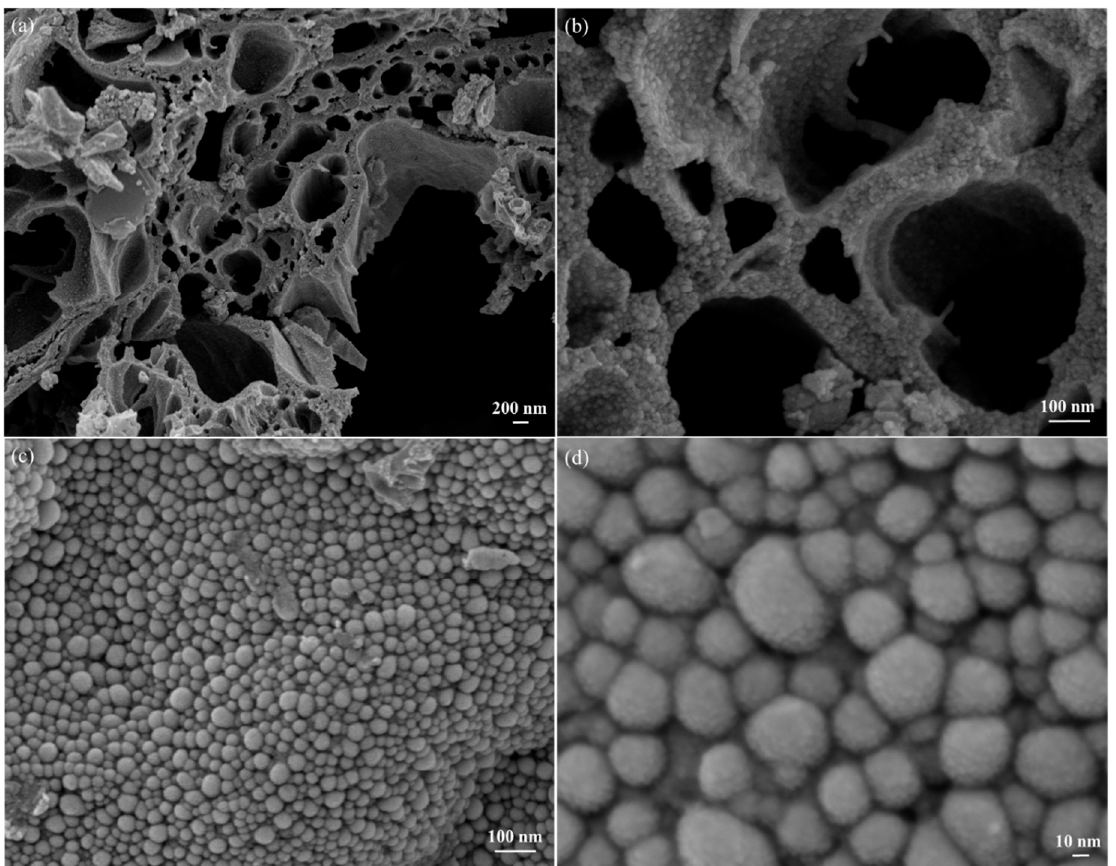
Figure 1. FESEM images of the biochar–BiO x sample: ( a ) at low magnification, ( b ) pore channels at high magnification, ( c ) pore walls at high magnification and ( d ) surface at high magnification.